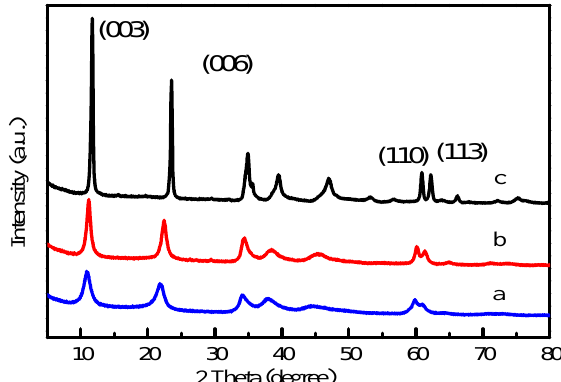
Figure 1. X ‐ ray diffraction (XRD) patterns of Mg(Al)O layered double hydroxides (LDHs) with different Mg:Al molar ratios: ( a ) Mg:Al = 2:1; ( b ) Mg:Al = 5:1; ( c ) Mg:Al = 10:1.